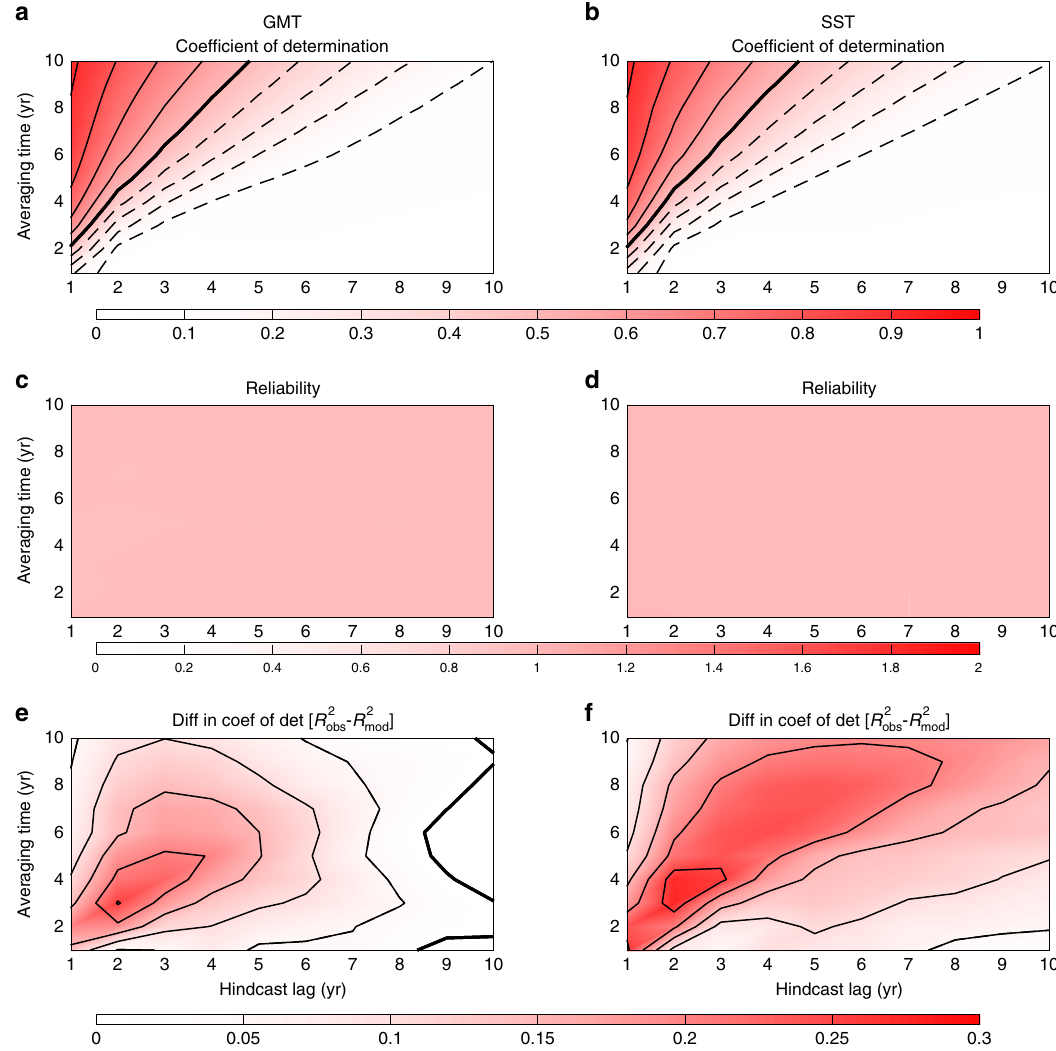
Fig. 4 Interannual hindcast skills of GMT and SST within a perfect model approach. a , b Skill of the prediction measured by the coef fi cient of determination — R 2 — between model observations and mean prediction for different hindcast lags and averaging times. The coef fi cient of determination between model observations and persistence (i.e., the null hypothesis of prediction) is also computed to give a benchmark. Thick contour lines represent values of 0.5, thin dashed — lower skill, and thin solid — higher skill, with contour intervals of 0.1; and hatching shows skill lower than the persistence. c , d Reliability of the prediction for different hindcast lags and averaging times. Note the absence of hatched region in a and b denoting the better skill than persistence for all hindcast lags and averaging times. Also, note the fl at pink color in c and d corresponding to a good reliability close to 1 for all hindcast lags and averaging times, as expected in a perfect model approach. e , f Difference between the coef fi cient of determination for the hindcasts with observations and within a perfect model approach ( a and b vs. Fig. 5c, d for GMT and SST). For all hindcast lags and averaging times, the skill is better for observations than for the perfect model approach. Thick black lines are for zero values, thin black lines are positive values with a contour interval of